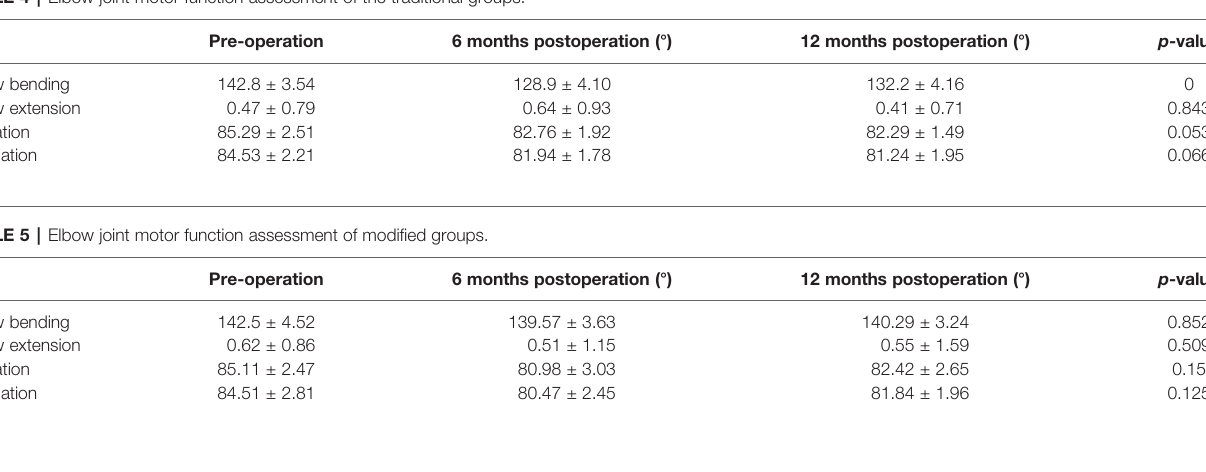
TABLE 4 | Elbow joint motor function assessment of the traditional groups.